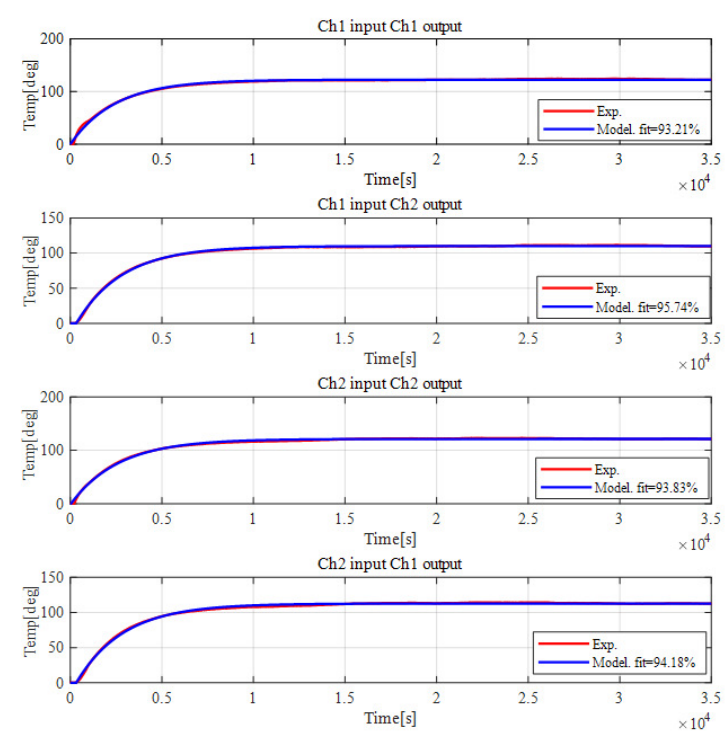
Figure 10. System identification